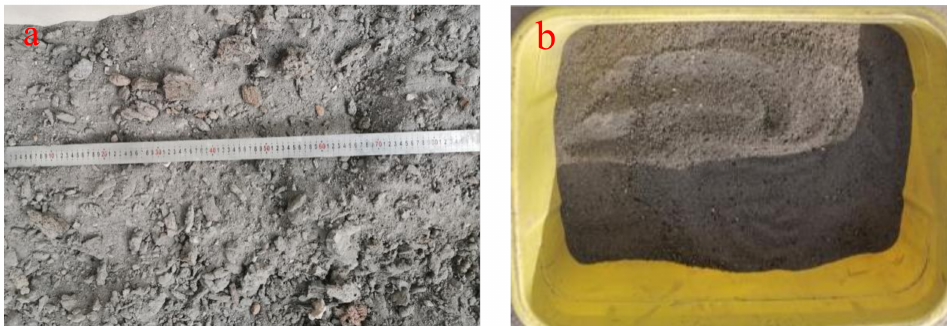
Figure 2. Slag before and after screening: ( a ) without screening treatment. These slag parti- cles are poorly graded and can not be directly used in construction. Therefore, through screen- ing test, the undisturbed slag is screened into 0–4.75 mm and the particle size range in ( b ) is experimentally